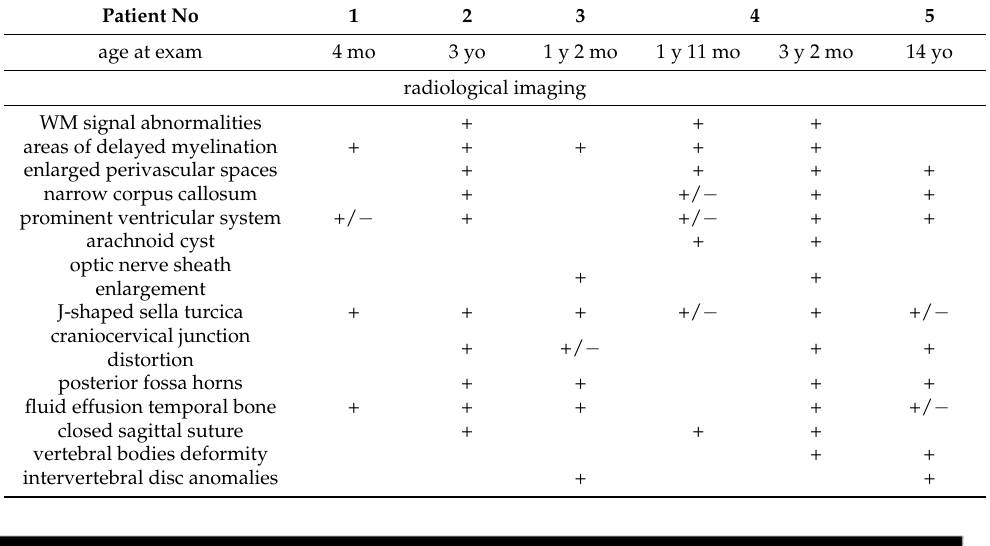
Table 5. Brain, head and spine. Radiological symptoms.